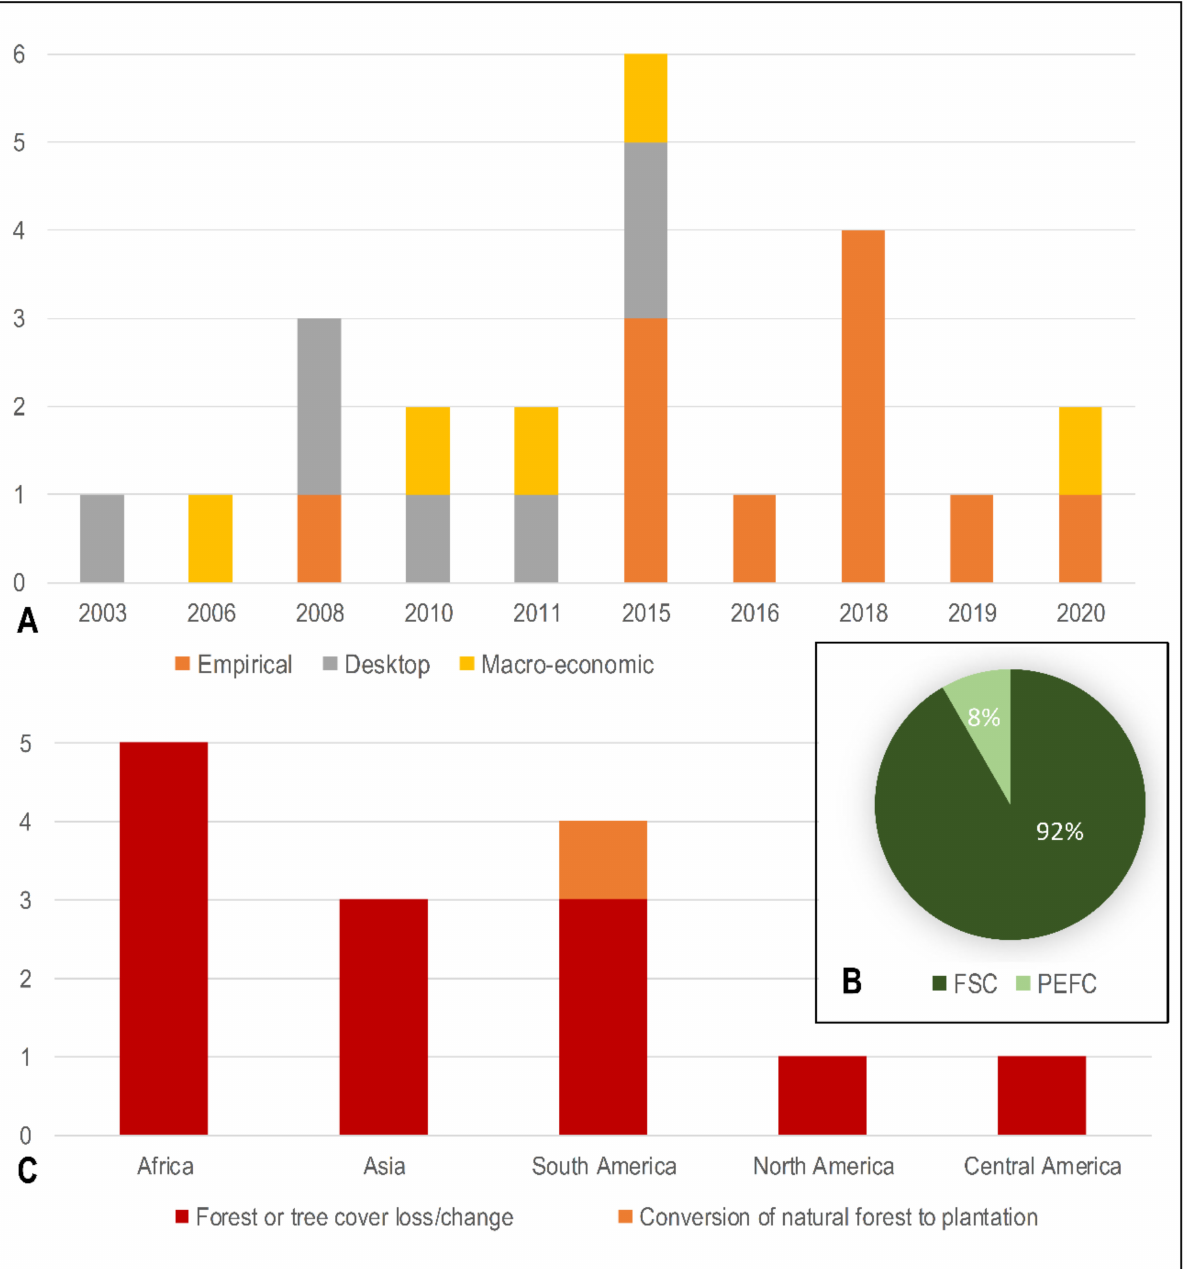
Figure 2. Number of publications on deforestation presented by year of publication and publication type ( A ). Share of certification scheme in the case studies ( B ). Distribution of empirical case studies, presented per world region and indicator (is not equal to the number of publications) ( C